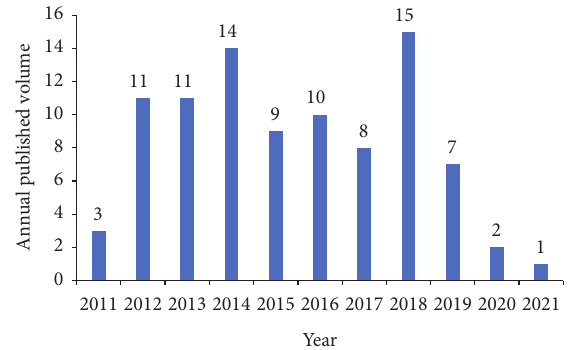
Figure 2: The annual published volume related to “consumption emotion” during 2011 ∼ 2021.